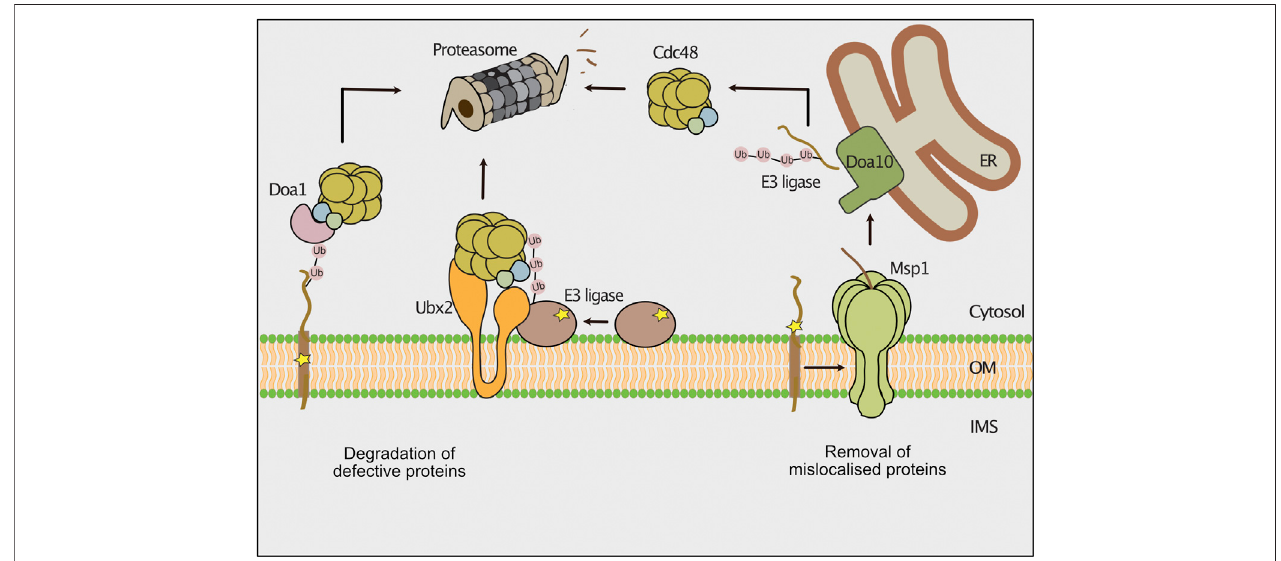
FIGURE 4 | Degradation pathways of outer membrane proteins. The cytosolic ubiquitin-proteasome system removes misfolded or mislocalized proteins from the outer mitochondrial membrane. Defective outer membrane proteins are ubiquitylated by different E3 ubiquitin ligases. The AAA-ATPase Cdc48 is recruited to the outer membranebyitsubiquitinbindingco-factorsDoa1andUbx2andpowerstheextractionofsubstrateproteinsforproteasomalturnover.TheAAA-ATPaseMsp1extracts mislocalized tail-anchored proteins from the outer membrane. TheER localized E3ubiquitin ligase Doa10ubiquitylatestheseproteins and Cdc48 delivers them for proteasomal degradation.